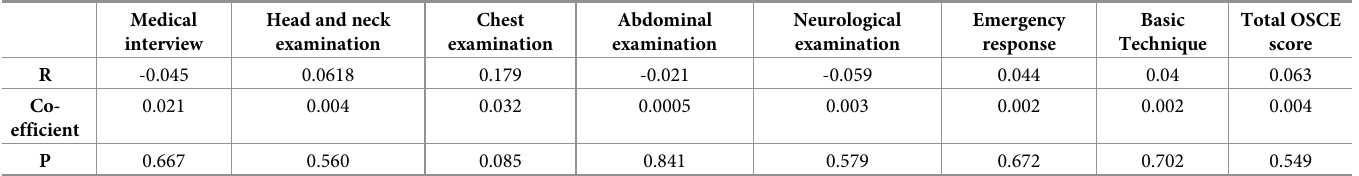
Table 3. Correlations between scores of objective structured clinical examination (OSCE) components and computer-based testing (CBT). Medical